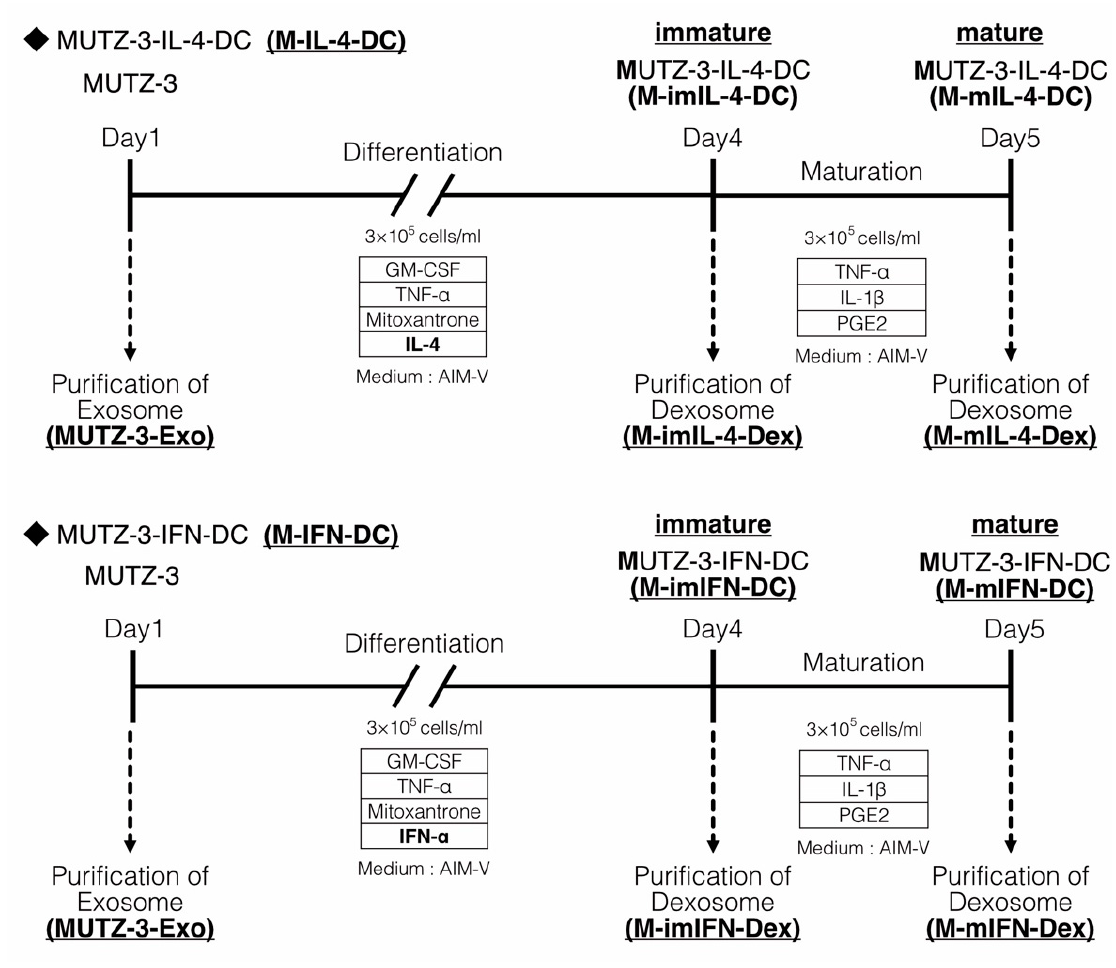
Figure 1. Protocol of MUTZ-3-derived Dendritic cell (DC) and dexosome induction. M-imIL-4-, M-mIL4-, M-imIFN-, and M-mIFN-DCs were generated as described in